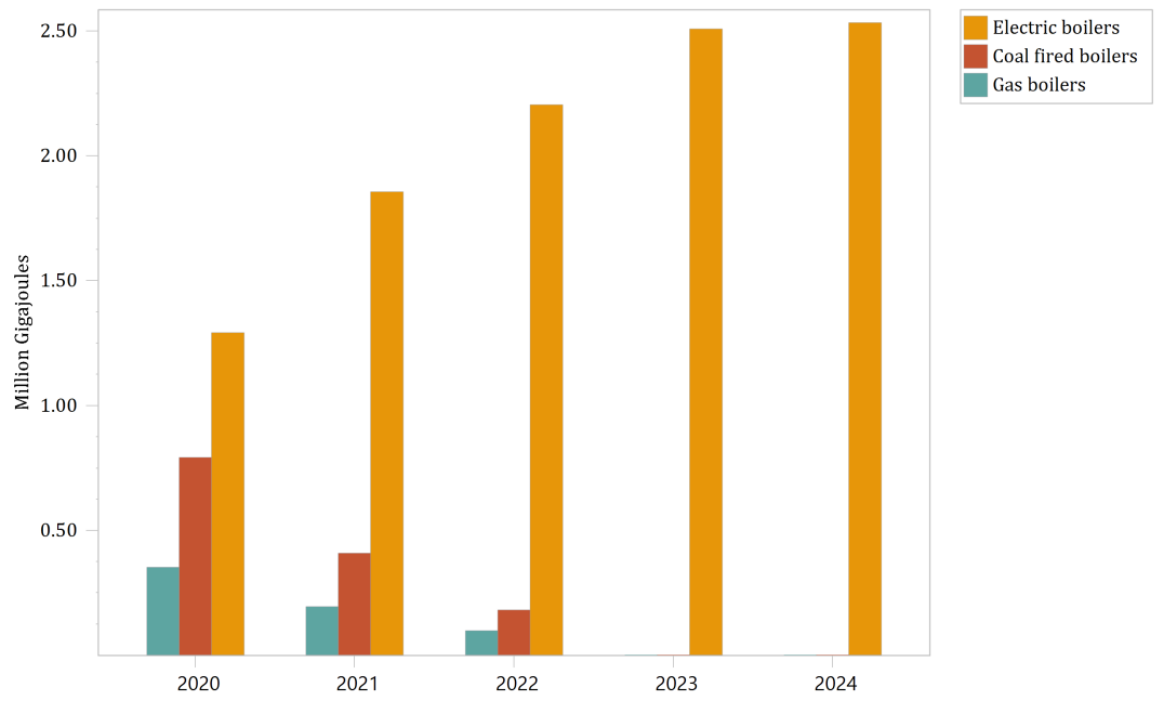
Figure 6. Boiler module energy demand trend in the boiler remediation scenario .